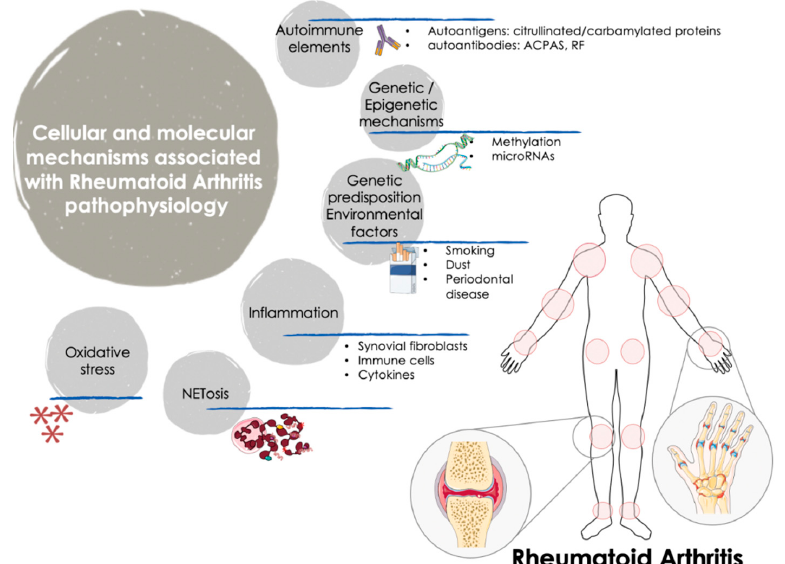
Figure 1. Cellular and molecular mechanisms involved in the pathogenesis of RA. The onset and progression of RA is orchestrated by several cellular and molecular pathologic mechanisms that participate in an integrated and coordinated way. The interaction between multiple genetic and environmental factors increase the risk of RA development. Autoimmune factors such as autoantigens and autoantibodies along with inflammatory mediators released by activated immune cells -including several cytokines and chemokines- are well recognized molecular features that influence the clinical manifestations of RA, characterized by tender and swollen joints and other related comorbidities.